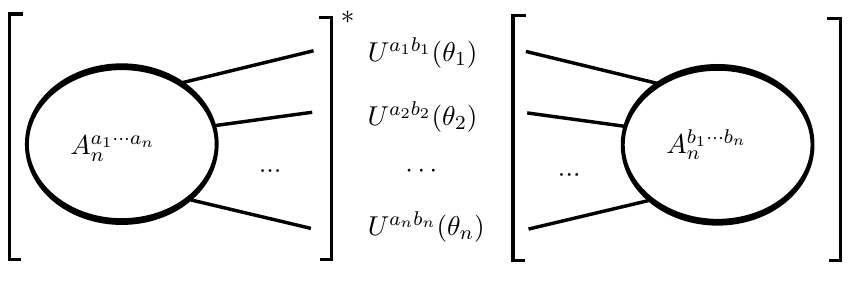
Figure 1 . Color density matrix. For each colored (cid:12)nal state, an independent color rotation is applied between the amplitude and its complex